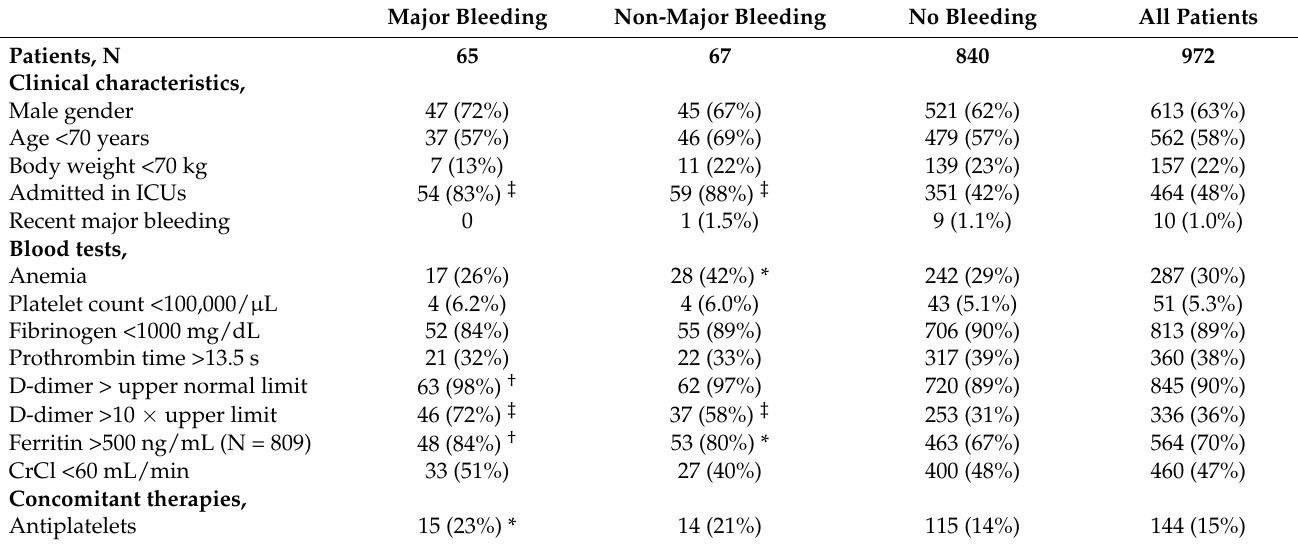
Table 2. Baseline characteristics of the patients, according to the development of bleeding